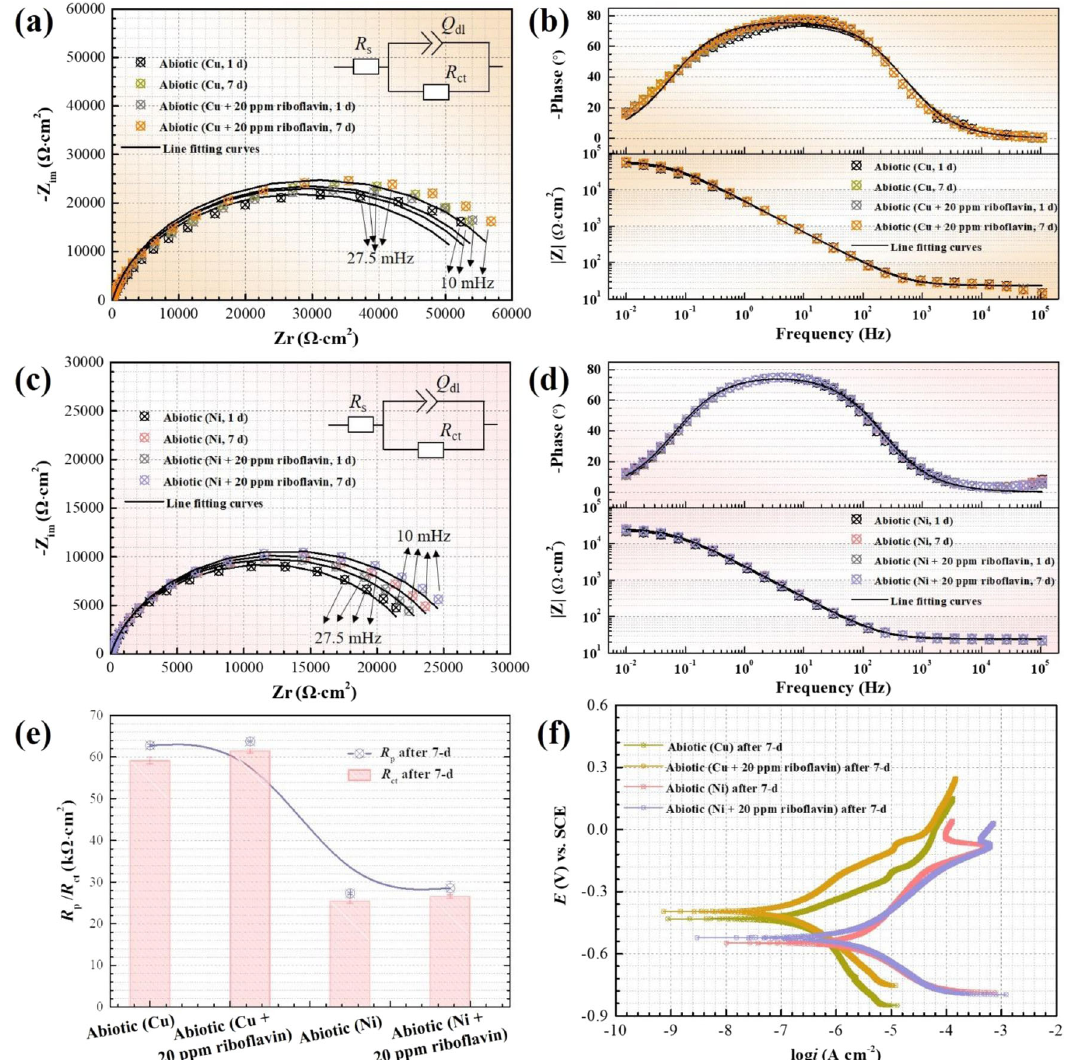
Fig. 9 Electrochemical measurement of the abiotic control. Nyquist and Bode plots of Cu ( a , b ) and Ni ( c , d ) coupons, R p and R ct from fi tted EIS parameters ( e ), Potentiodynamic polarization curves ( f ) of Cu and Ni after the 7-d immersion in the sterile medium without and with ribo fl avin. (Error bars stand for the standard deviations from at least three independent